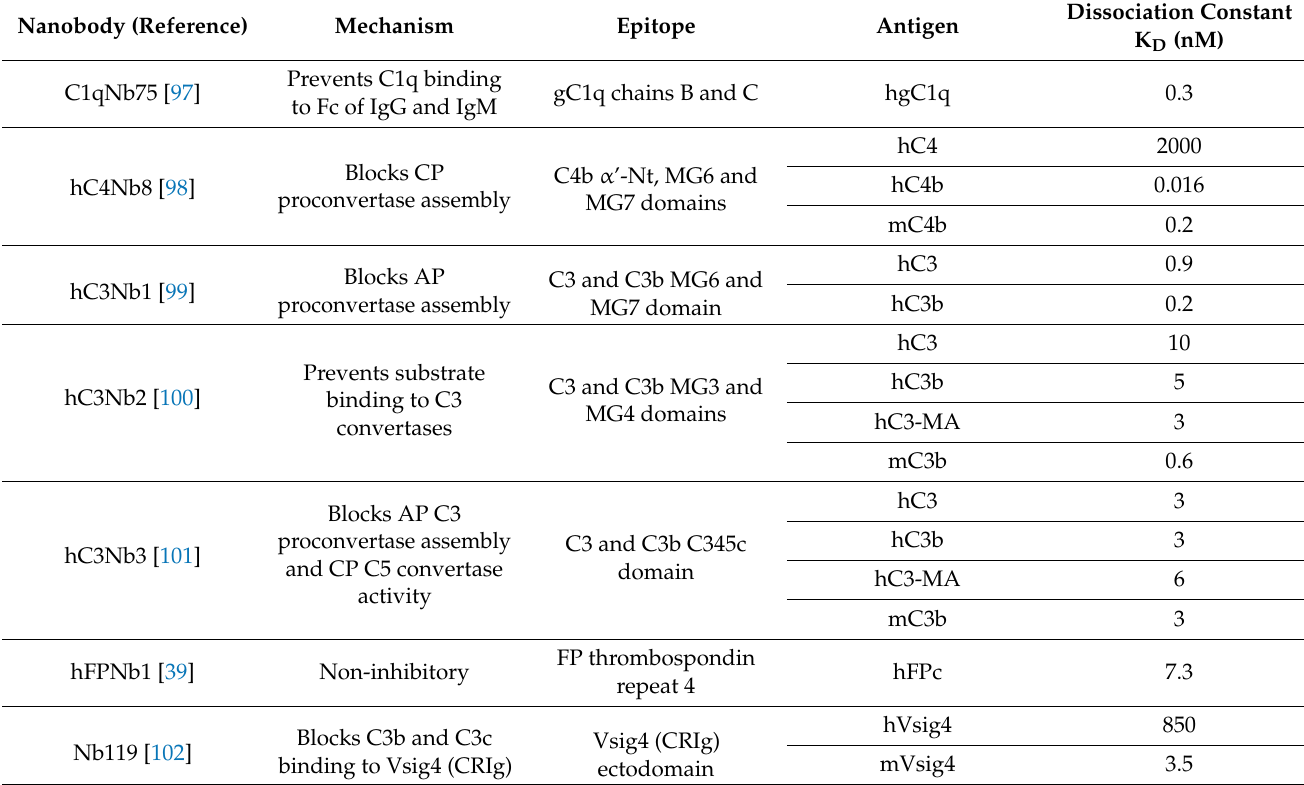
Table 1. The complement targeting nanobodies presented in this review. The table outlines the inhibitory mechanism of each nanobody, its epitope and antigen. Dissociation constants are given toward different forms of the targeted complement component, and toward the mouse component when